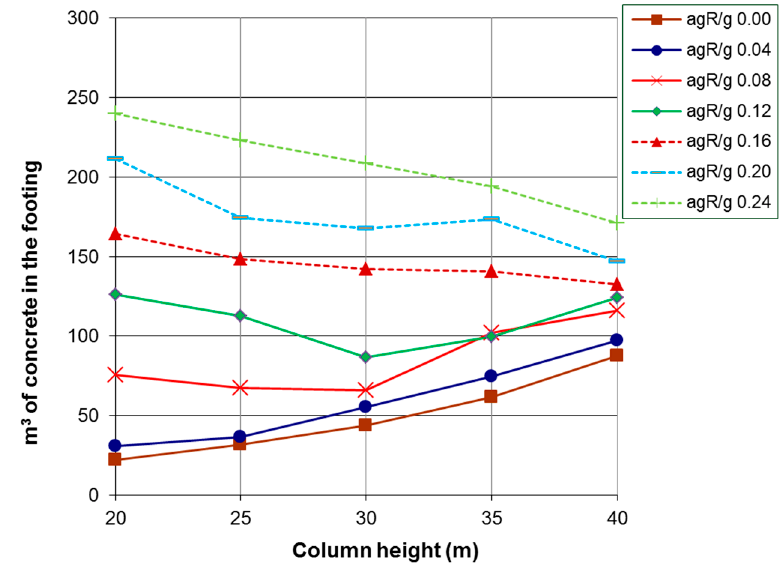
Figure 13. Footing volume of concrete versus height of the column.